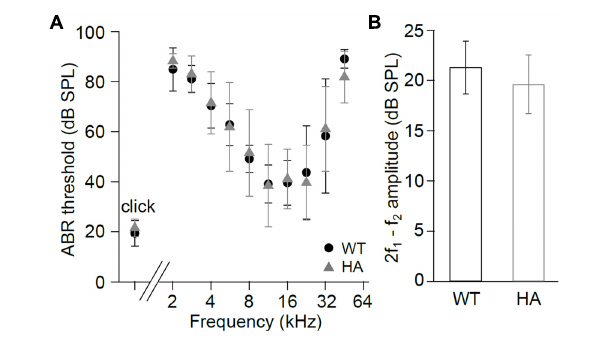
FIGURE 8 | Hearing function in Cav1.3DCRD HA / HA mice. (A) ABR thresholds (mean ± SD) of Cav1.3DCRD HA / HA mice were normal for click stimuli (WT and Cav1.3DCRD HA / HA : n = 8/16 animals/ears) and as a function of stimulus tone frequency (WT: n = 6/12 animals/ears and Cav1.3DCRD HA / HA : n = 7/13 animals/ears). Thresholds could be measured in ( n = animals/ears, frequency in kHz): WT: 2/3, 2; 6/9, 2.8; 6/12, from 4 to 22.6; 3/6, 32; 3/6, 45.2; Cav1.3DCRD HA / HA : 2/3, 2; 7/13, from 2.8 to 32; 4/8, 45.2. (B) Mean DPOAE maximum amplitudes (signal to noise ratio) ± SD at f1 = 9.1 kHz, L1 = 55 dB SPL, f2 averaged over 10–18 kHz, and L2 = 45 dB SPL were normal in Cav1.3DCRD HA / HA ( n = 7/14 animals/ears) compared with WT mice ( n = 7/14 animals/ears, p = 0.12), indicating normal function of the cochlear